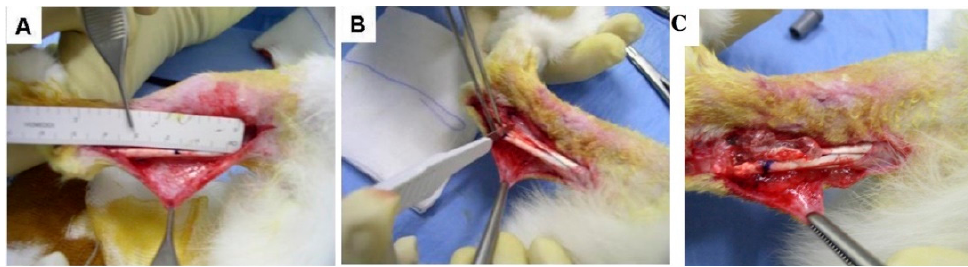
Figure 1. Surgical steps. ( A ) Approach to the tendon. ( B ) Tendon damage is performed. ( C ) Hyaloglide ® application to the tendon injury site.